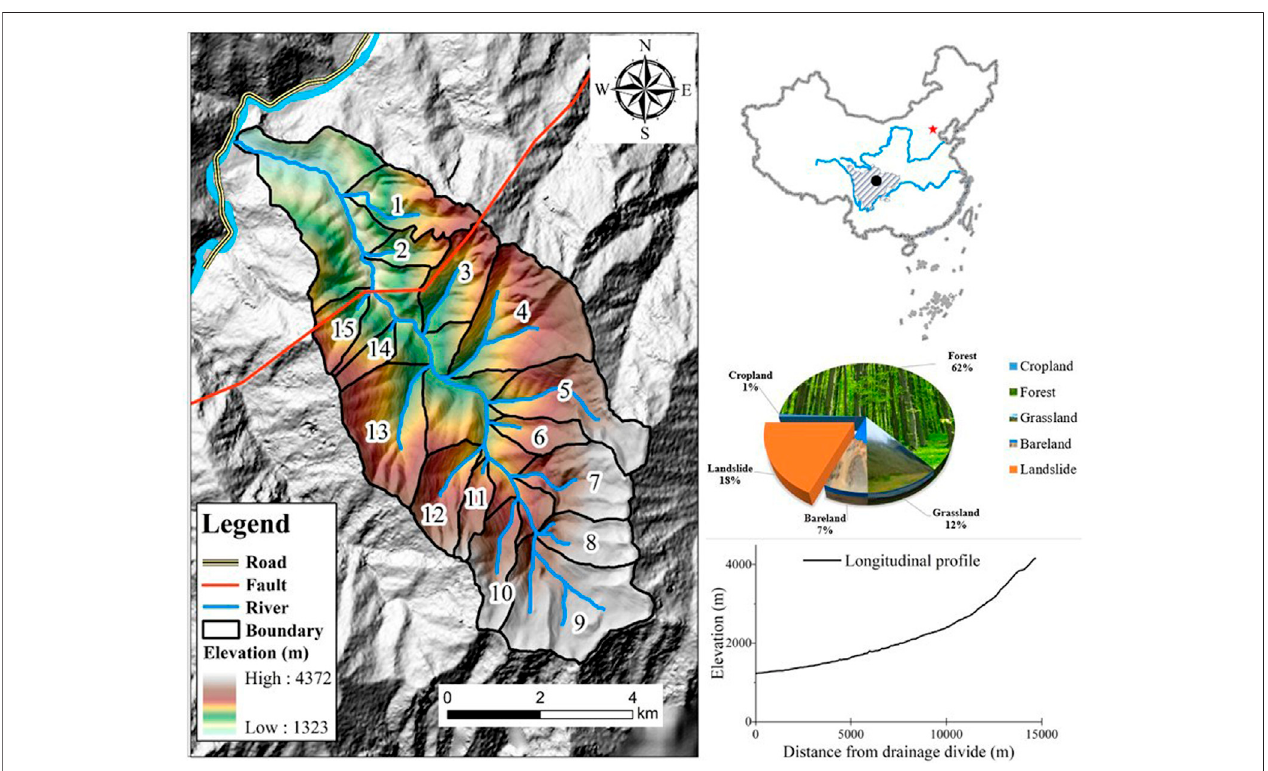
FIGURE 1 | Topography, land use, and channel pro fi le of the Qipangou Valley.